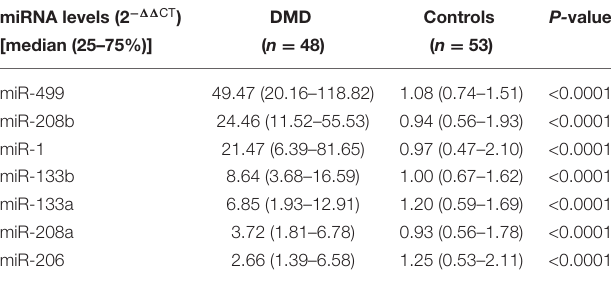
TABLE 2 | Serum levels of myomiRs in DMD patients vs.